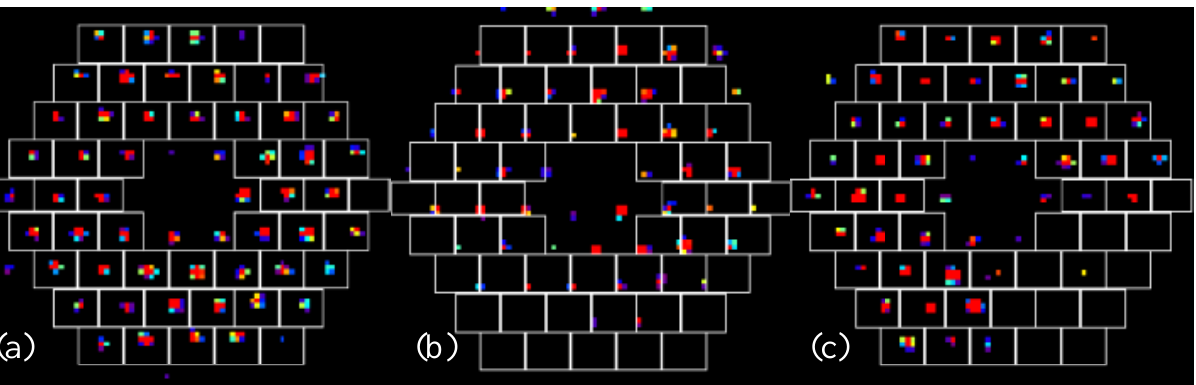
Figure 1. Three typical situations for the wavefront are under-sampled with the sub-aperture of S-H WFS. ( a ) a single sub-aperture lack of light, ( b ) a row of sub-apertures at the bottom lack of light, ( c ) a quadrant sub-aperture lack of light.